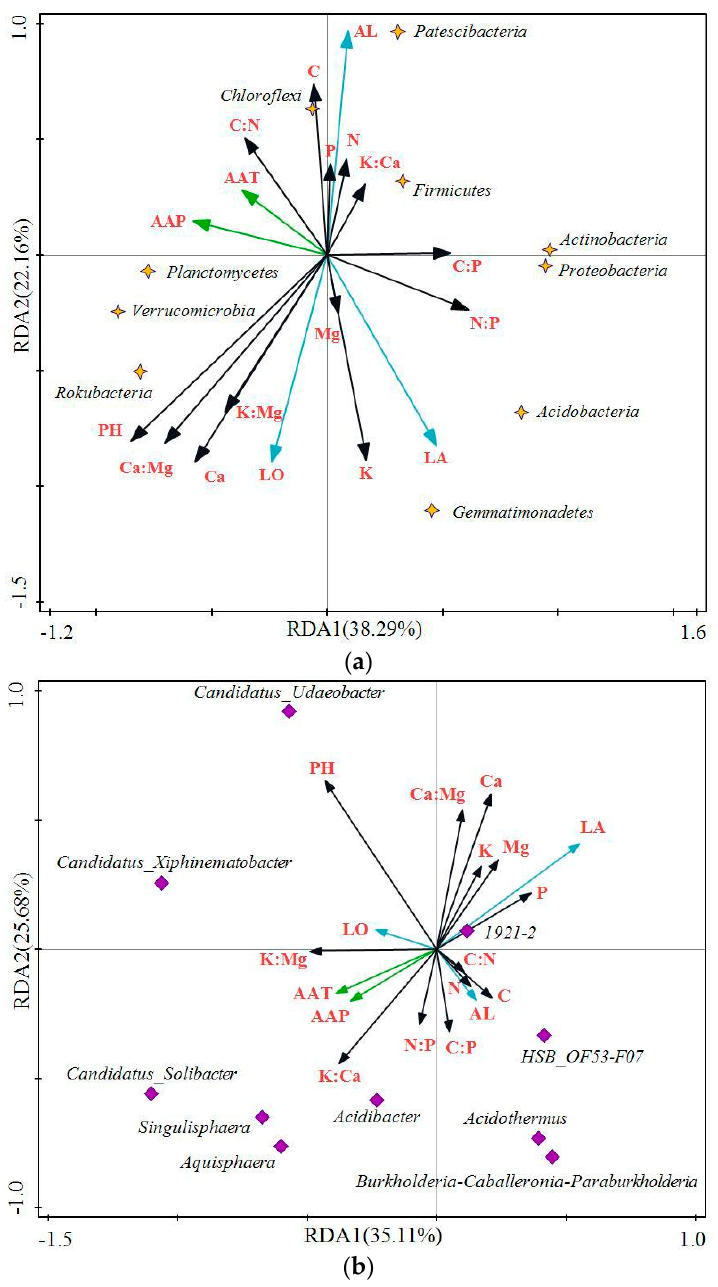
Figure 6. Redundancy analysis relating phylum ( a ) and genus ( b ) to selected environmental factors (shown as arrows). The lengths of these arrows show relative significance, whereas the angle between the arrows and the axis reflects the degree to which they are correlated.